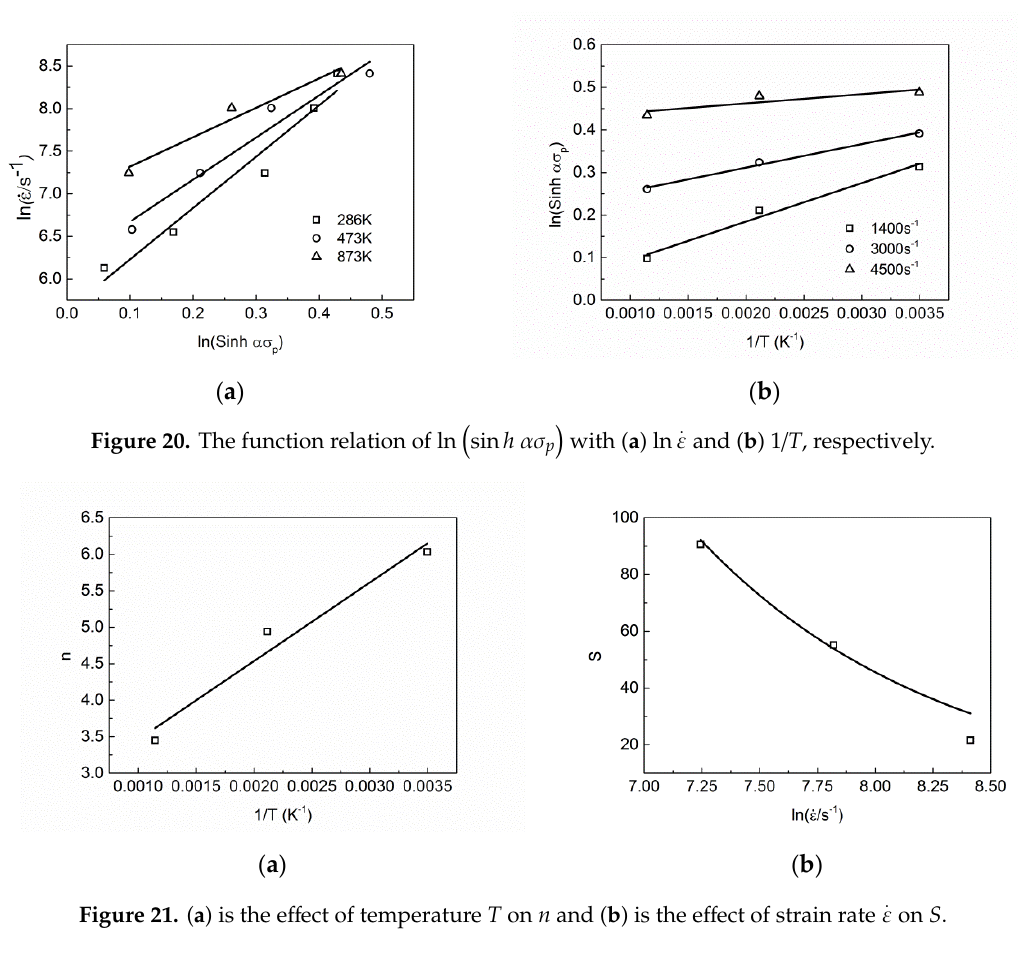
Figure 21. ( a ) is the effect of temperature T on n and ( b ) is the effect of strain rate 𝜀̇ on S.